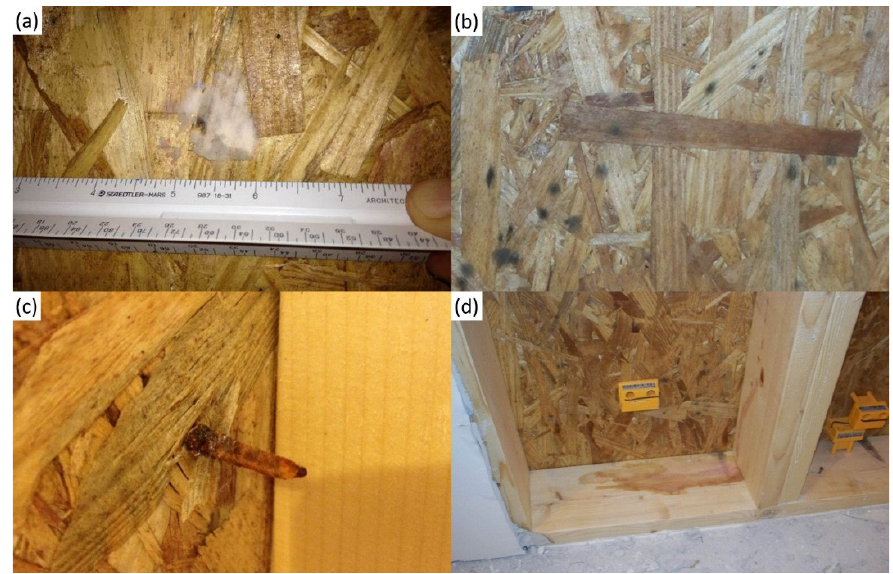
Figure 8. Observations indicating high moisture levels in the cavity of Wall 8b: ( a , b ) Mold growth; ( c ) Corrosion on siding nail; ( d ) Staining on bottom